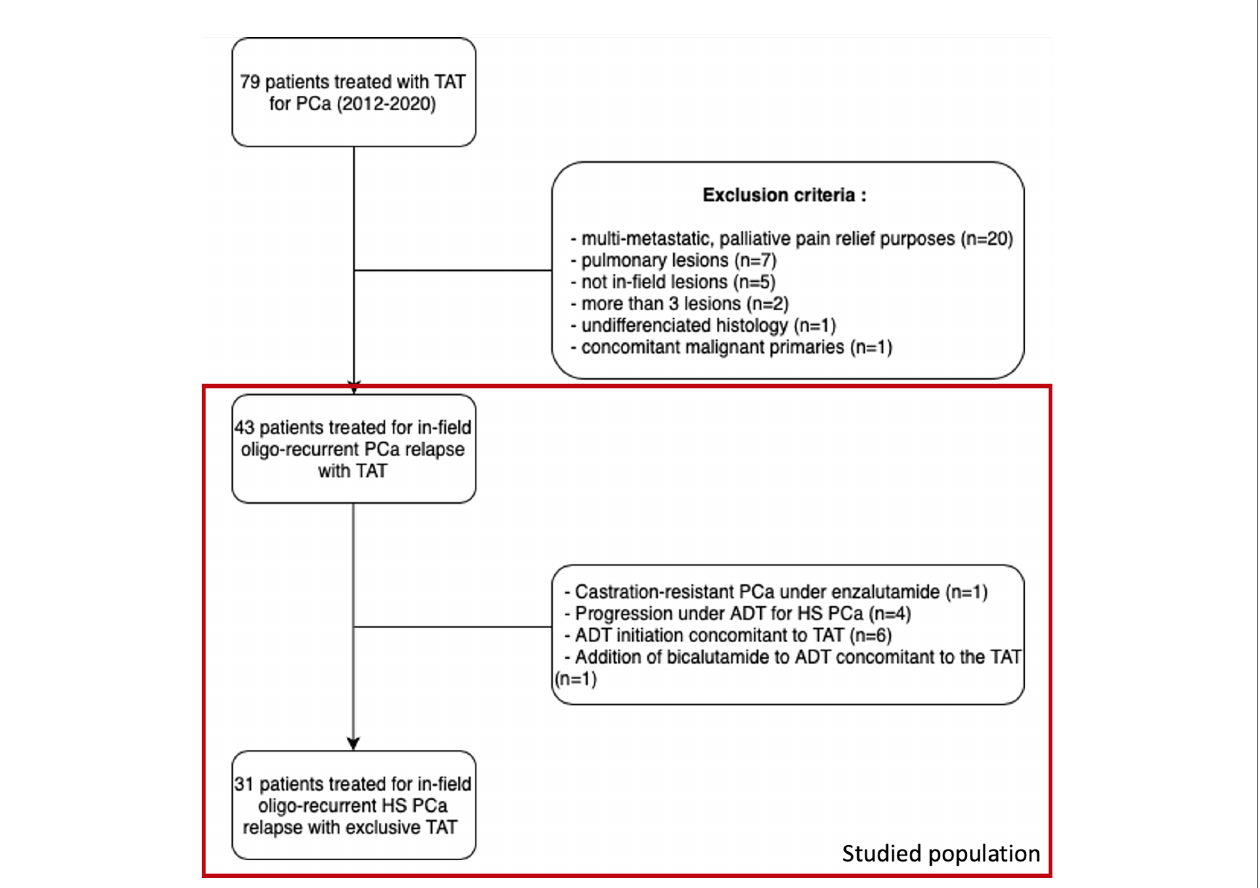
FIGURE 2 | Flowchart of patient selection. TAT, thermo-ablative therapy, PCa, prostate cancer, ADT, androgen deprivation therapy, HS,